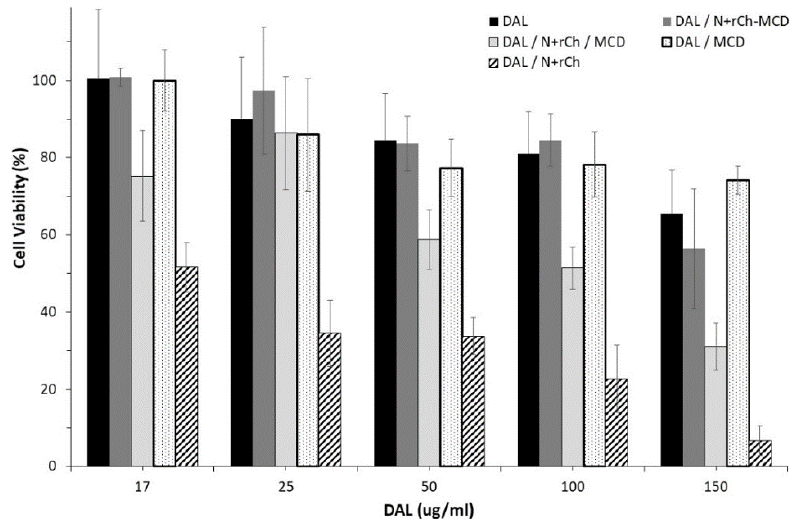
Figure 8. Caco-2 cells cell viability assay. Error bars indicating SD values of eight replicates.